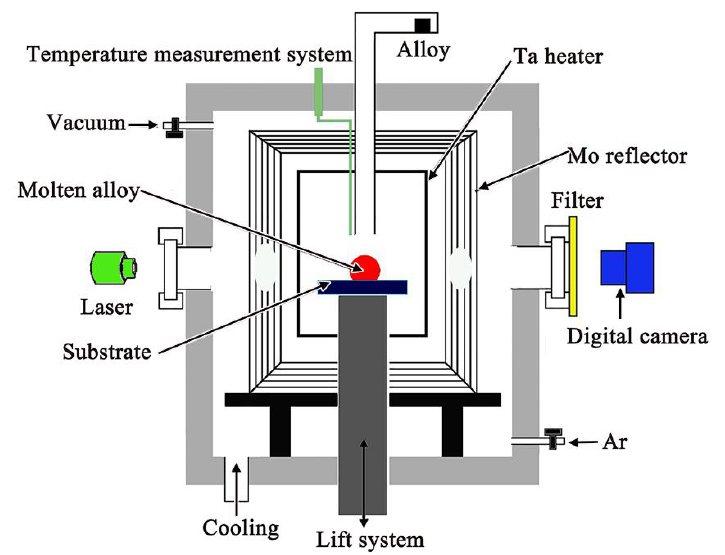
Figure 1. Schematic diagram of the improved sessile drop equipment.